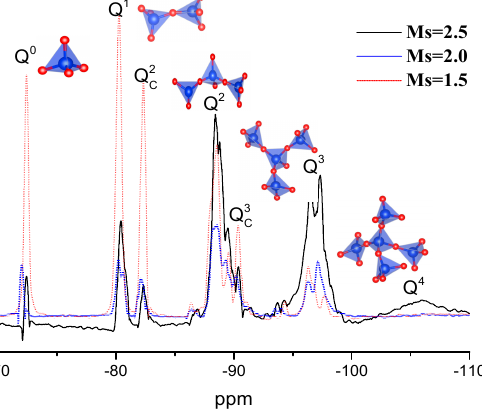
Figure 3. 29Si NMR results for silicon in the alkaline activator solution.